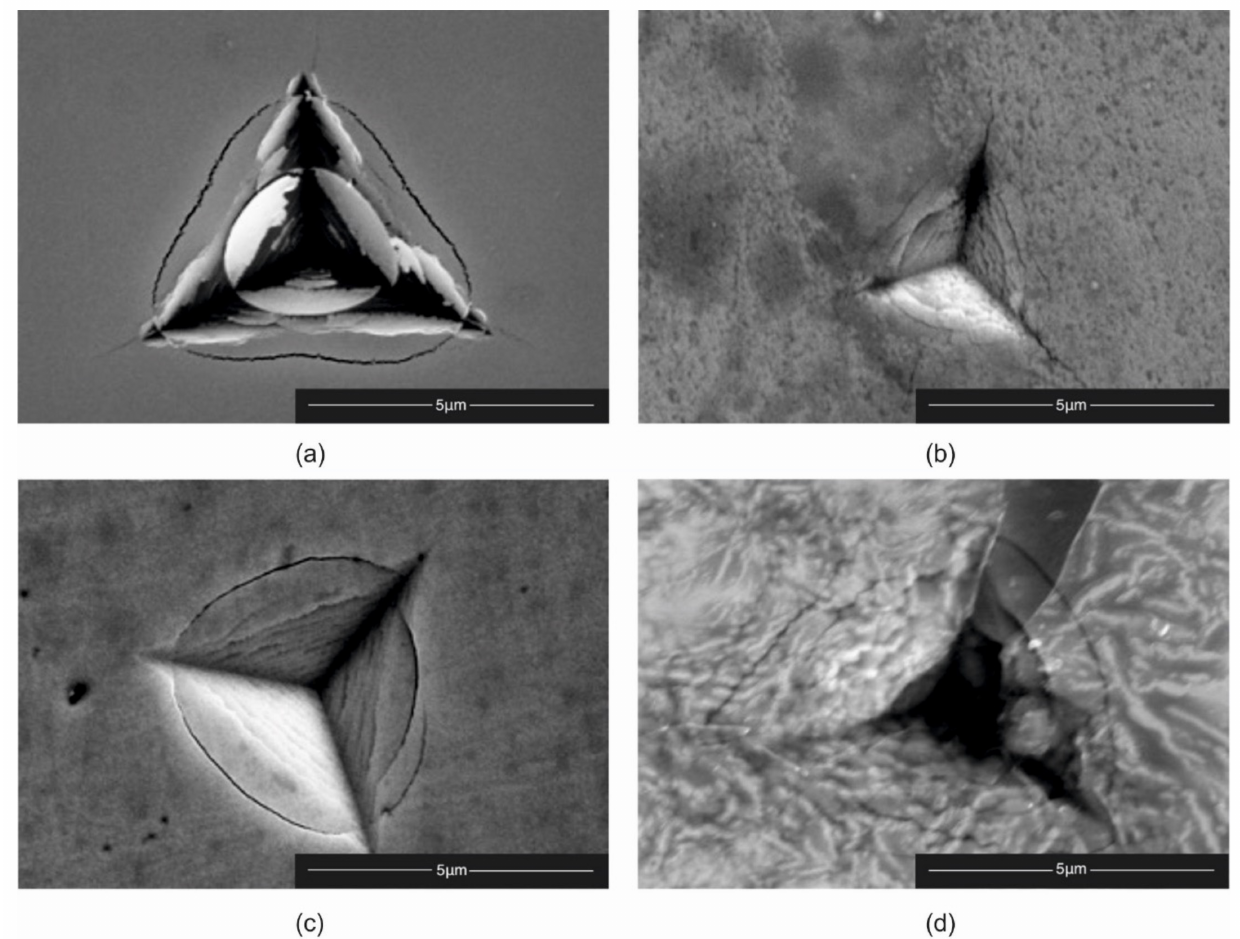
Figure 10. SEM images of the Berkovich indenter with load of 350 mN for K IC for: ( a ) TiB 2 ; ( b ) Ti 0.78 W 0.22 B 2 ; ( c ) Ti 0.58 W 0.42 B 2 ; and ( d ) Ti 0.5 W 0.5 B 2